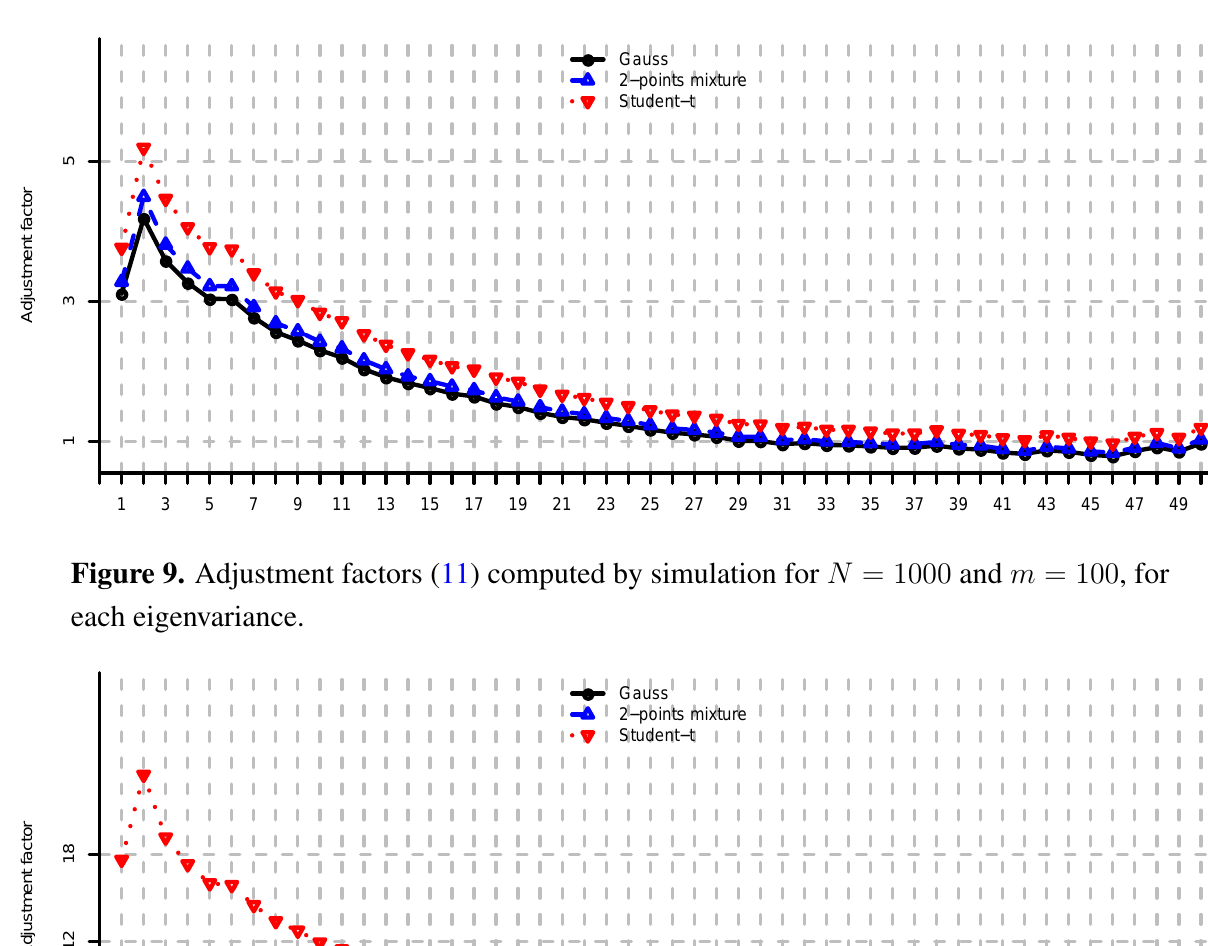
Figure 8. Adjustment factors (9) computed by simulation for N = 1000 and m = 100 , for each eigenvariance.